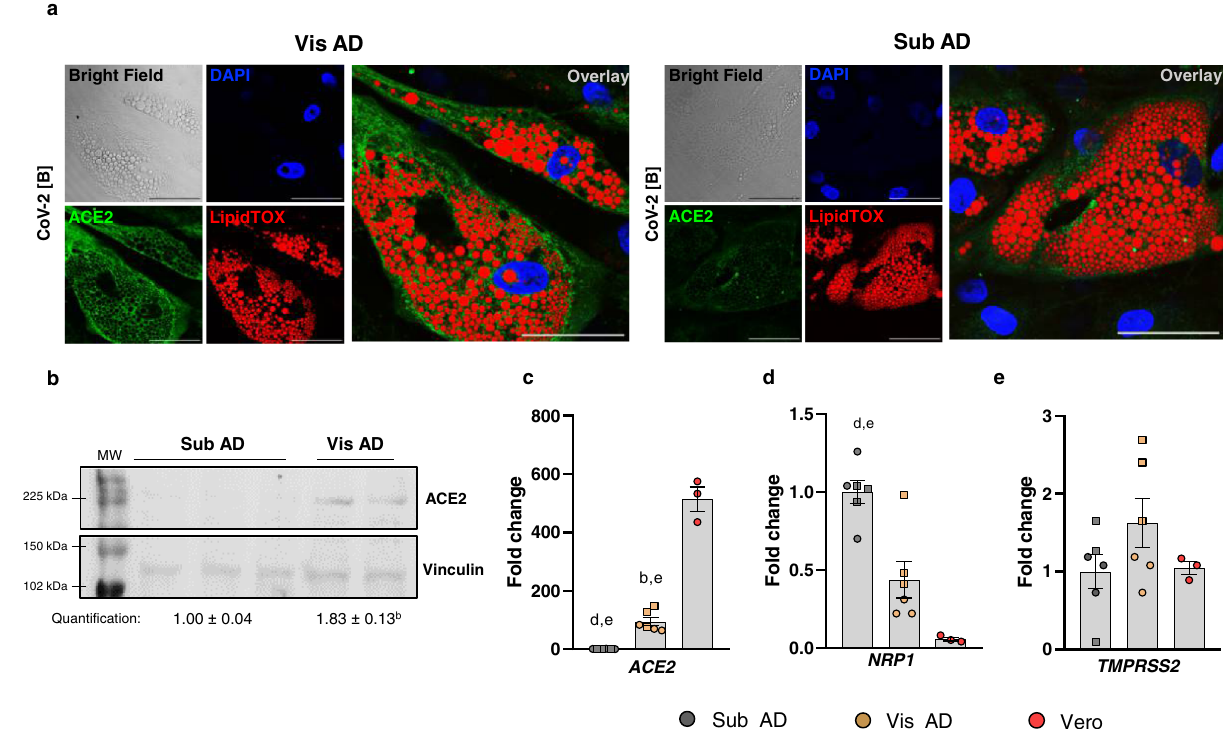
Fig. 3 | Visceral adipose tissue cells express more ACE2 than subcutaneous adipose tissue cells. Human adipose tissue-derived stromal-vascular cells from subcutaneous and visceral fat depots were differentiated into adipocytes (Sub AD andVisAD,respectively). a Representativeimmuno fl uorescenceofVisADand Sub AD cells infected with CoV-2(B) (MOI=0.1 for 1h and harvested 3 days after infection) evidencing ACE2 expression. DAPI, blue. ACE2, green. LipidTOX, red. Scale bar=50 µ m. Representative of eight to ten images acquired from two to fi ve independentpoolsofcellsfromtwotothreedonors. b Westernblottingcomparing the basal levels of ACE2 in uninfected Sub AD ( n =3 donors) and Vis AD ( n =2 donors)cells.Two-tailedStudent ’ s t -test:b, P <0.01.MW,molecularweight. c – e